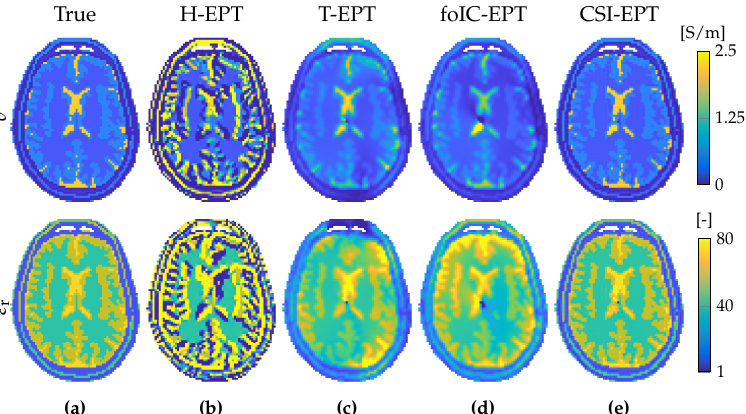
Figure 3. Local method and global methods comparison on simulated two-dimensional noiseless data from a 7 T head coil. Methods are two-dimensional implementations. True model ( a ), Helmholtz- based EPT ( b ), Transverse EPT ( c ), first-order Induced-Current EPT ( d ) and contrast source inversion EPT ( e ). Conductivity (top row) and relative permittivity (bottom